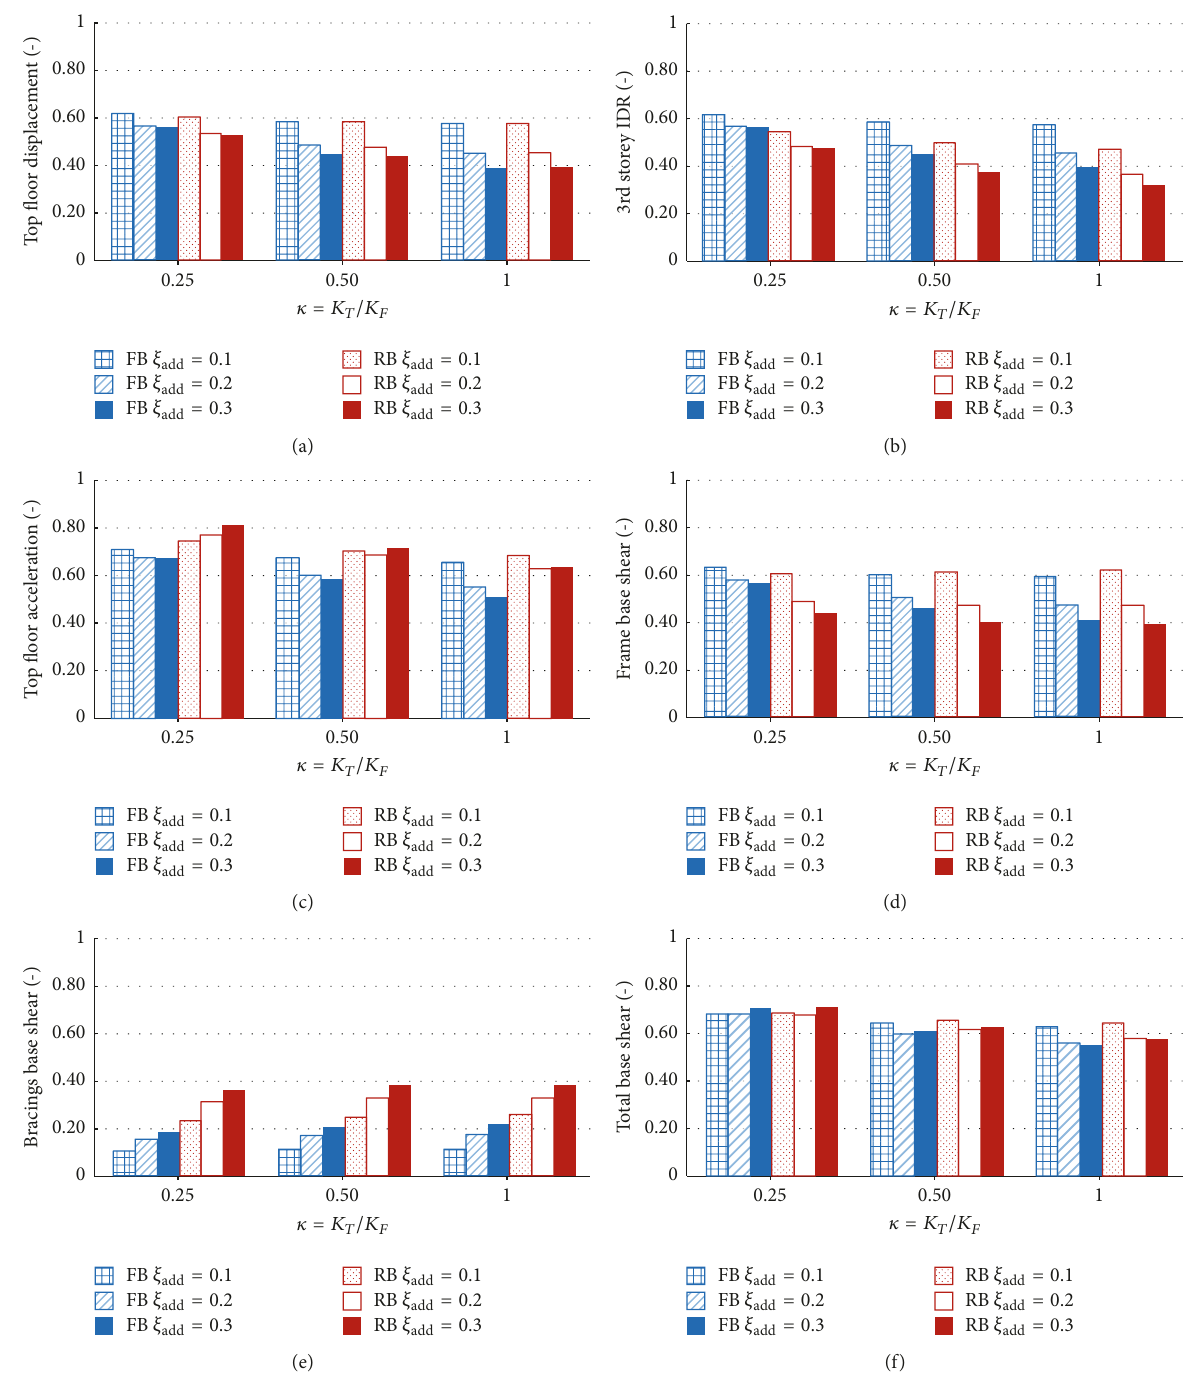
Figure 12: Results of the parametric analysis for the FB and RB configurations in terms of different EDPs of interest.